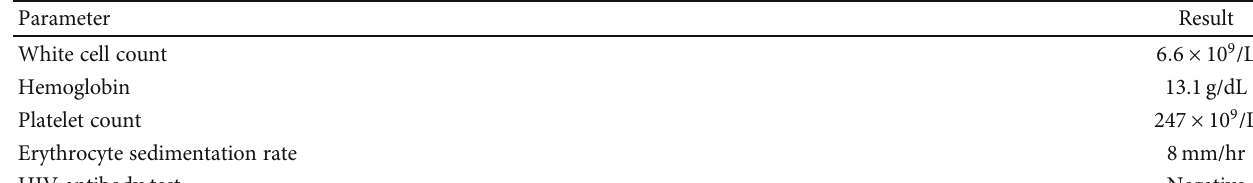
Table 1: Baseline laboratory investigations.